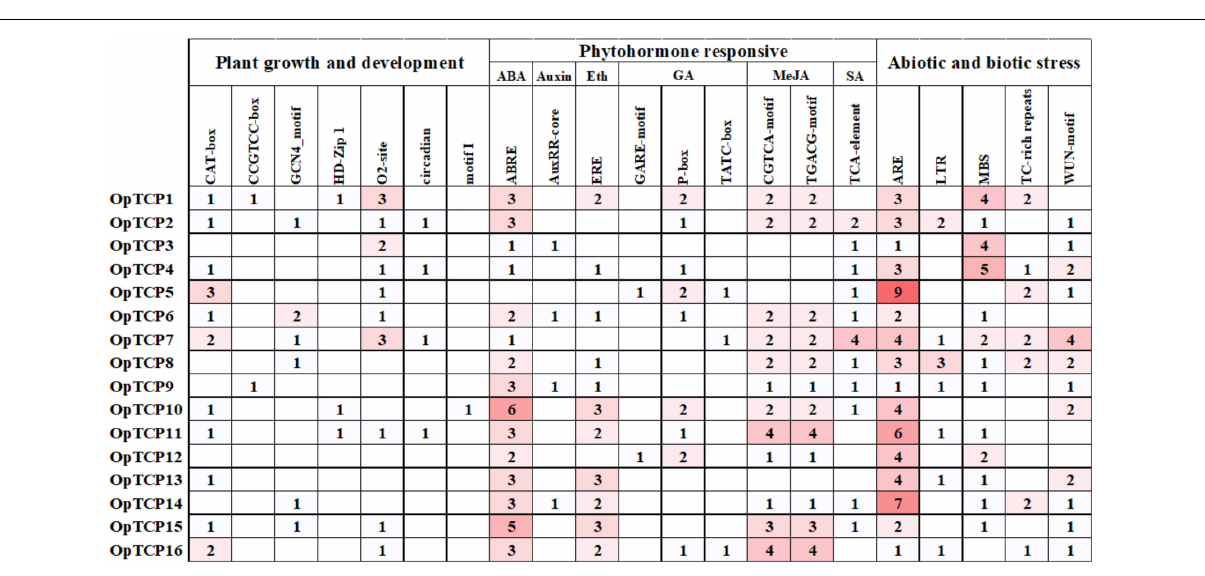
FIGURE 4 | Promoter cis -regulatory elements analysis of the OpTCP genes. Based on the functional annotation, the cis -acting elements were classified into three major classes: plant growth and development, phytohormone responsive, or abiotic and biotic stresses-related cis -acting elements (detailed results shown in Supplementary Table 5